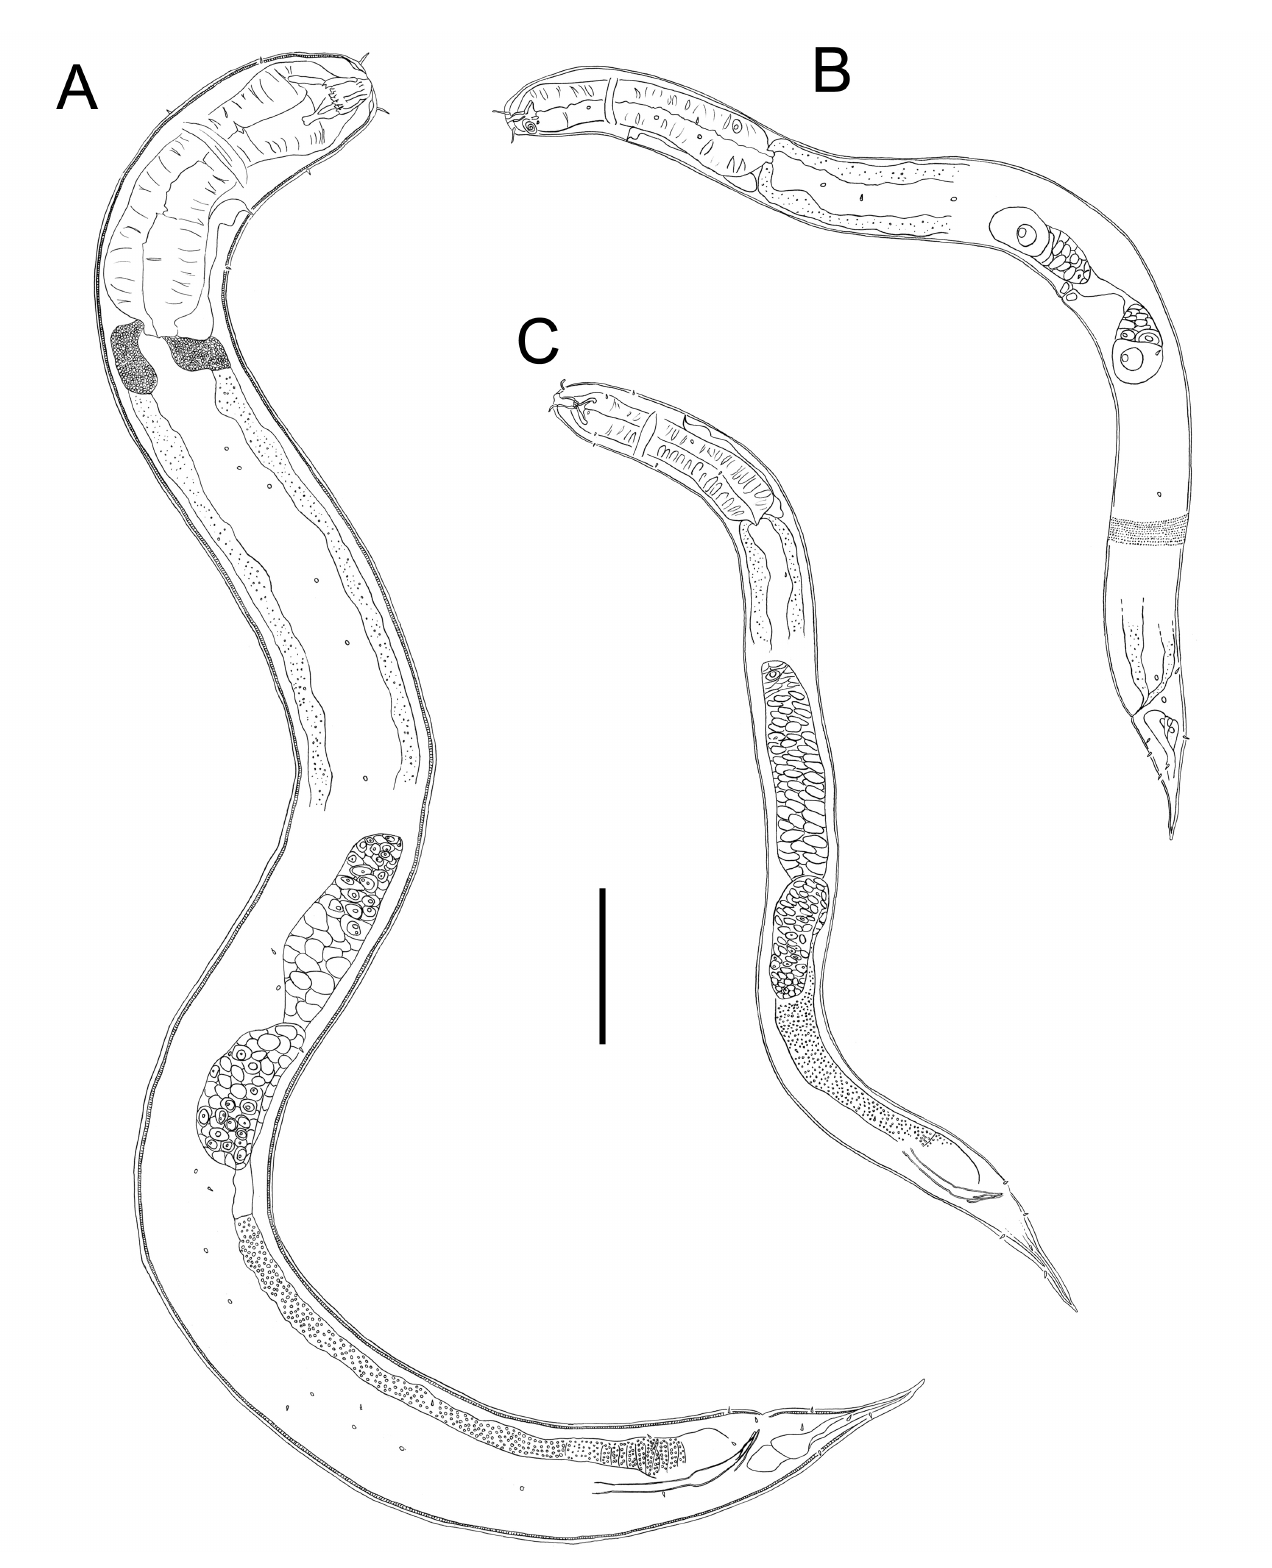
Fig. 9. Cobbionema trigamma sp. nov. A . Entire holotype. B . Entire female. C . Entire male paratype. Scale bar = 100